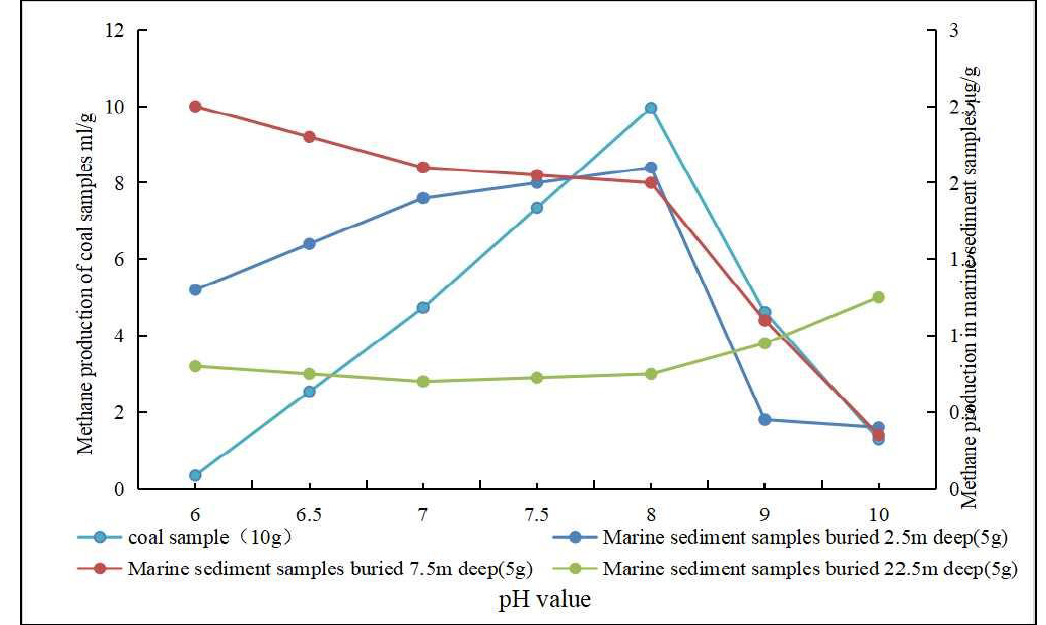
Figure 4. The relationship between pH and gas production (Adapted from [101,102]).